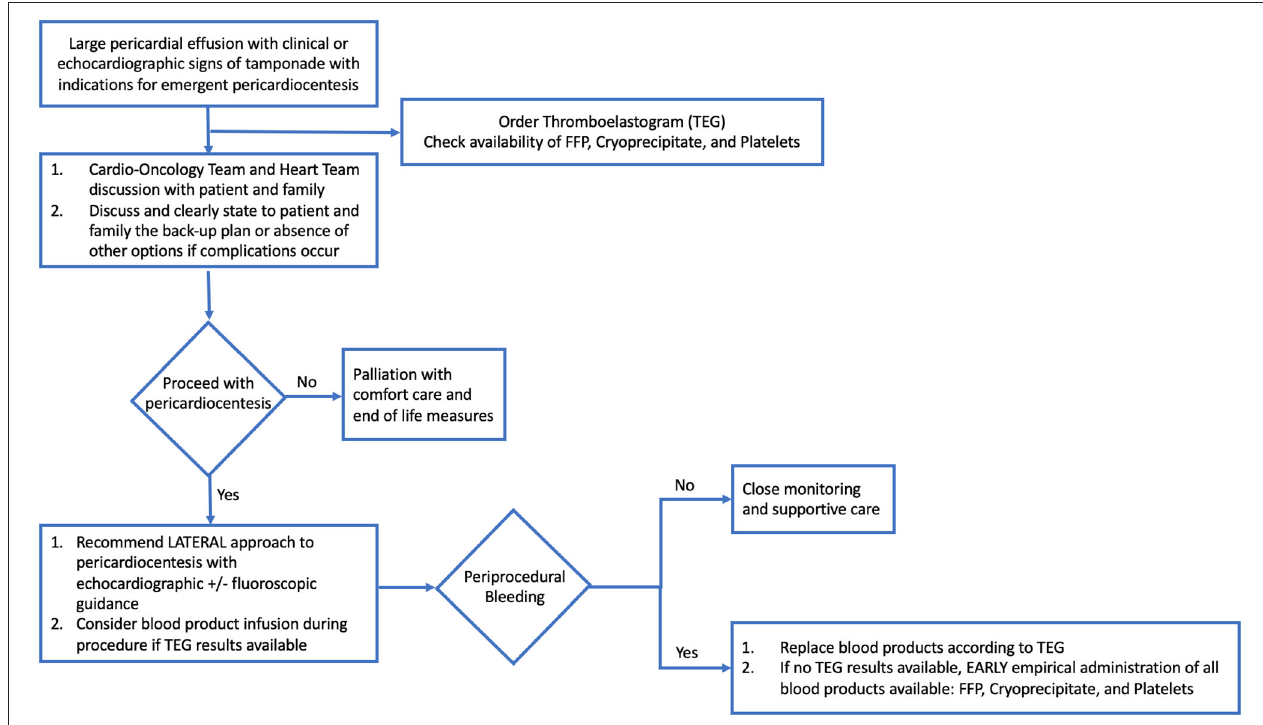
FIGURE 3 | Flow-Chart: Approach to large pericardial effusion in patient with malignancy. Hemodynamically significant pericardial effusion in a patient with malignancy is a complex clinical scenario, one which requires appropriate clinical coordination, laboratory evaluation, and preparation. Important factors include a multidisciplinary discussion with Cardio-Oncology Team, Heart Team, patient and family members to discuss risks, benefits, and back-up options for complications, as well as consideration of palliation and comfort care measures. If proceeding with pericardiocentesis, recommended procedural approach is lateral and with echocardiographic ± fluoroscopic guidance, plus consideration of blood product administration based on laboratory results and thromboelastogram results. In the setting of periprocedural bleeding, early replacement of blood products according to TEG results or empiric administration of all blood products available is of paramount importance, in addition to achieving hemostasis and ongoing supportive